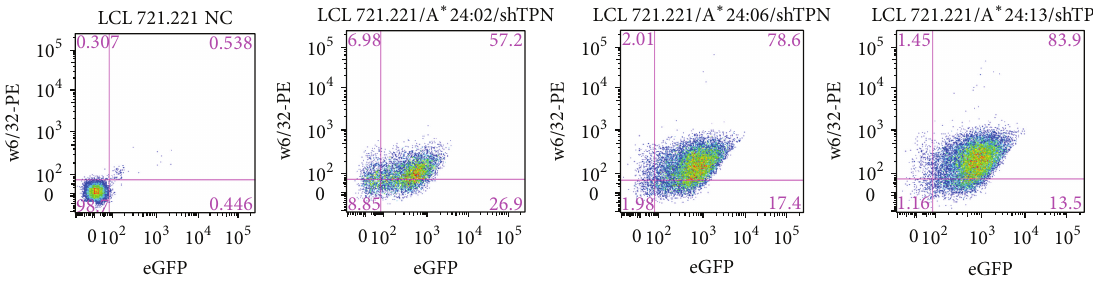
Figure 2: Silencing of TPN does not affect the relative surface expression of HLA-A ∗ 24/156 variants. Expression of HLA-A ∗ 24/156 variants on the surface of 721.221 cells transduced with shRNA targeting TPN. Flow cytometric analysis for GFP (reporter gene from pLVTHM/si vector) and w6/32-PE showed all the HLA-A ∗ 24/156 variants to be GFP positive. BothHLA-A ∗ 24:06 and HLA-A ∗ 24:13 were highly positivefor w6/32 ( ∼ 80%) while relatively lower percentage of A ∗ 24:02 was positive for w6/32 ( ∼ 60%) thus confirming relative levels of TPN independence exhibited by the HLA-A ∗ 24/156